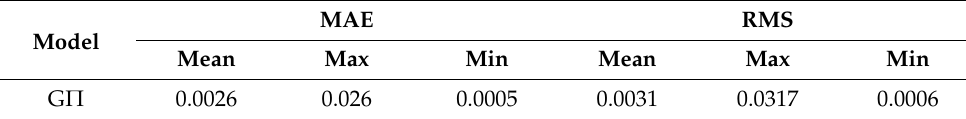
Table 1. Statistics results: internal accuracy testing of the G Π model.